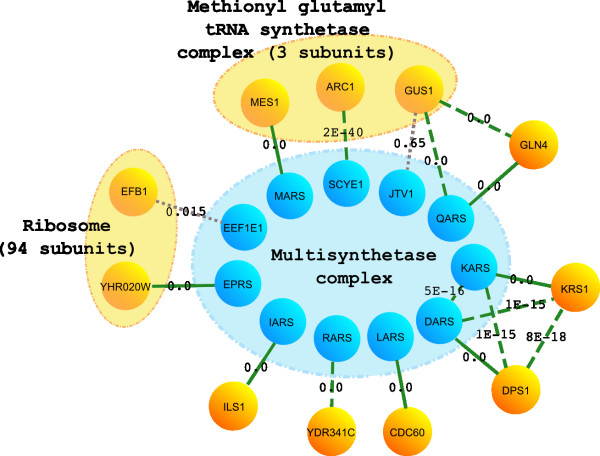
The Multisynthetase complex. Yeast homologs were detected for all subunits of the Multisynthetase complex. Green solid lines link proteins which are together in an Inparanoid cluster, green dashed lines indicate a significant BLAST hit between the two proteins linked, gray dashed lines indicate insignificant BLAST hits between proteins for which homology is confirmed by the co-complex network alignment.